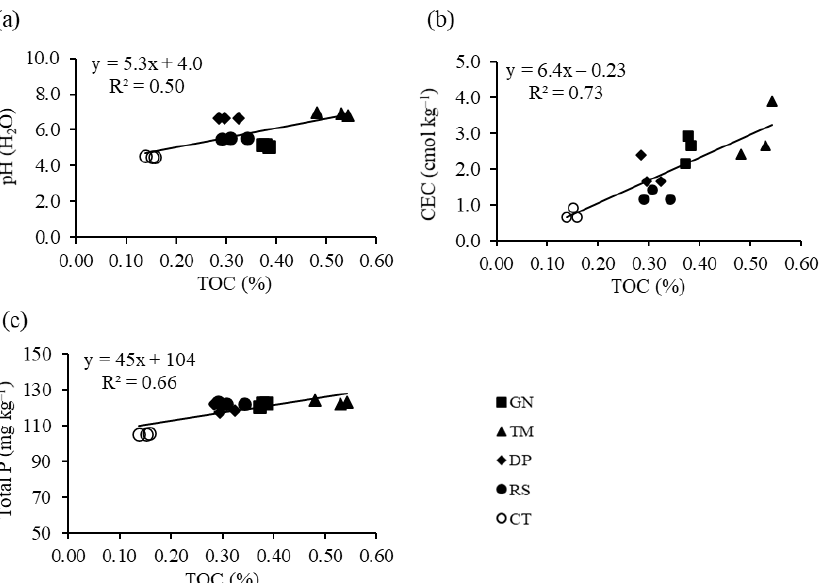
Figure 1. Bivariate relationships between total organic carbon (TOC) and pH (H 2 O) ( a ), TOC and cation exchange capacity (CEC) ( b ), and TOC and total P ( c ) for the tropical sandy soil under the incorporation of organic residues of differing biochemical quality.